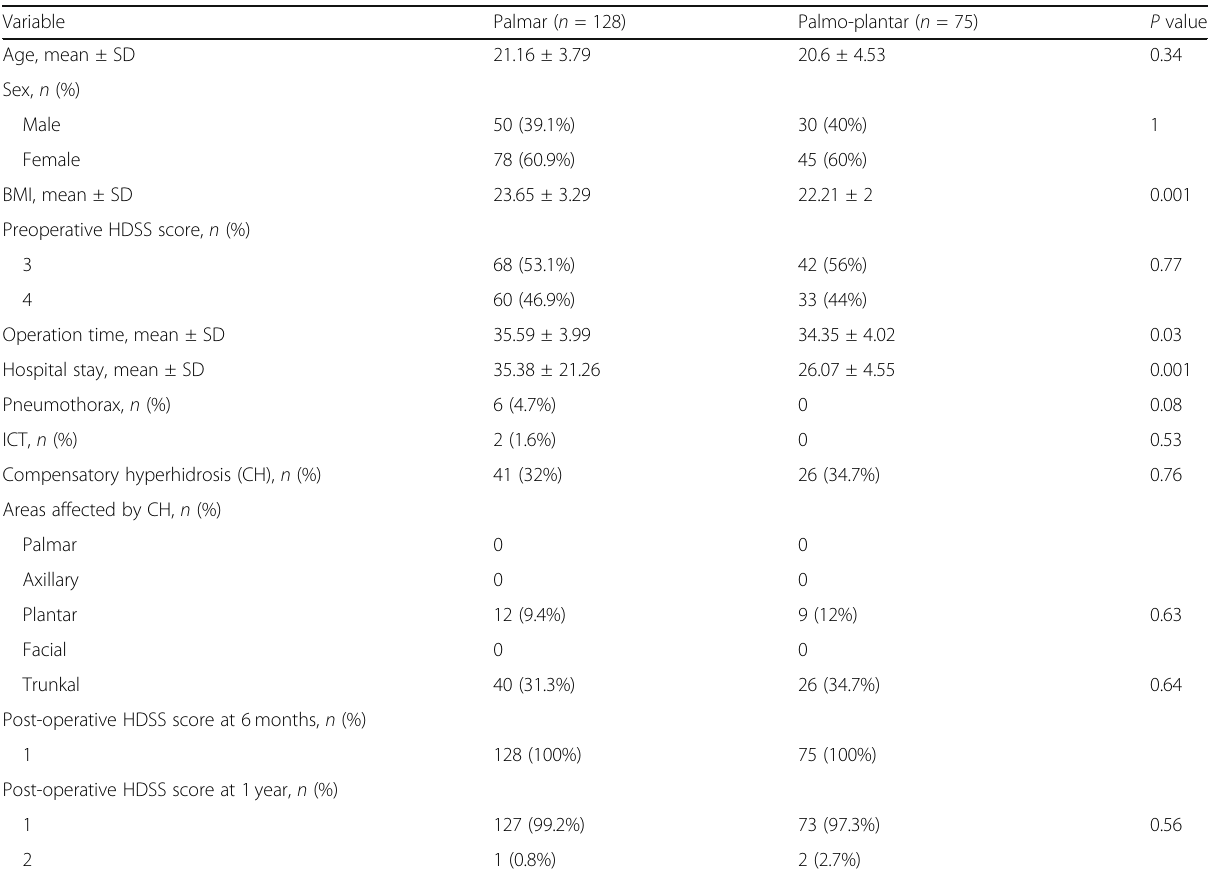
Table 4 Palmar versus palmo-plantar outcome